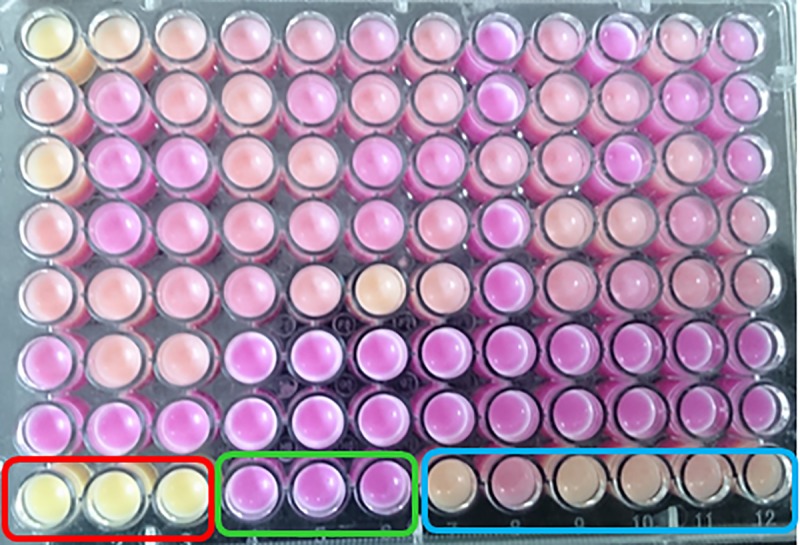
Change of pH due to hydrolysis of triglyceride by mutants of GTL indicated by phenol red.Wells in red rectangle are positive controls (pH <6, without lipase), in green rectangle are negative controls (pH 9.5, without any lipase) and in blue rectangle are with GTL. Acidic samples are yellow in colour (due to activity of lipase) and alkaline samples are purple in colour.